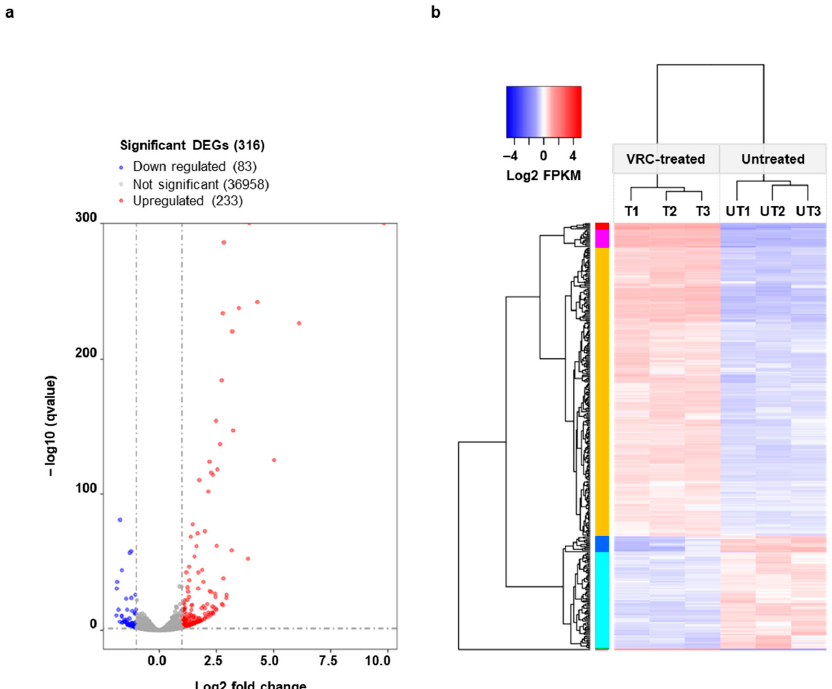
Figure 2. Genes differentially expressed in the presence of VRC. ( a ) Volcano plot of differentially expressed genes (DEGs) showing the log10 q -value (y-axis) vs. log2 fold change (x-axis). The cut-off values (dotted grey lines) used to define significant DEGs were a q -value of < 0.05 and a log2 fold change > |1|, i.e., larger than 2-fold. ( b ) Heatmap dendrogram (blue = down-regulation, red = up-regulation) for the normalized mRNA expression levels (log2 of FPKMs) of the 316 DEGs relative to their combined average expression levels for each of the three biological replicates grown in the absence (UT1, UT2, UT3) or presence (80 min; T1, T2, T3) of sub-growth inhibitory concentrations of VRC (16 mg/L). The hierarchical clustering indicates biologically meaningful results. Colours of the vertical bar next to the y-axis dendrogram indicate different levels of down-regulation (cyan-blue) or up-regulation (orange-magenta-red) of groups of transcripts.